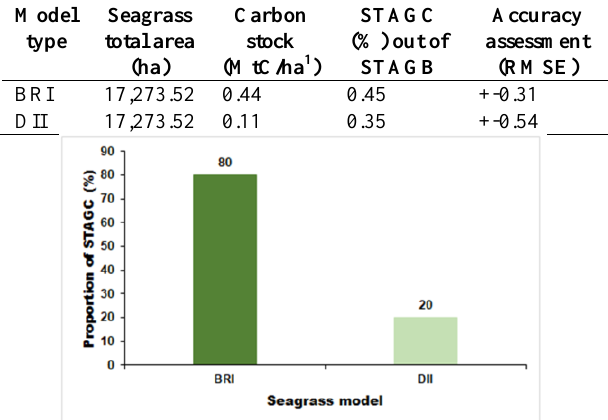
Figure 5. The differences between the proportions of STAGC estimated using BRI and the other with DII model. As revealed earlier, the bands blue and red were employed in this study was due to the better capability of the blue band in penetrating water when compared with other bands. Whereas, the green band functionality is similar to that of the blue band, not as excellent as a blue band.